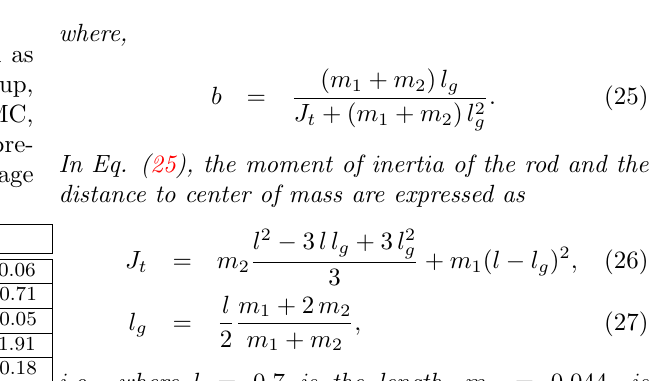
i.o., where l = 0 . 7 is the length, m 2 = 0 . 044 , is the mass of the pendulum arm (neglecting the load), m 1 = 0 . 2 , is the mass of the load and g = 9 . 81 is the gravitational constant. A schematic model of the Table 8: Results from Sec. 3.1. PID controllers orga- inverted pendulum on a cart is shown in Figure 12. nized as ( K p , T i , T d ) for Alg. 2.1 and runner- up, i.e. SIMC, with exception of row 4, K- SIMC, and the optimal controller, PO-PID, for prescribed robustness, M st = 1 . 59 or in- put usage M ks = 50, (i.e. only ‘and’ for col.